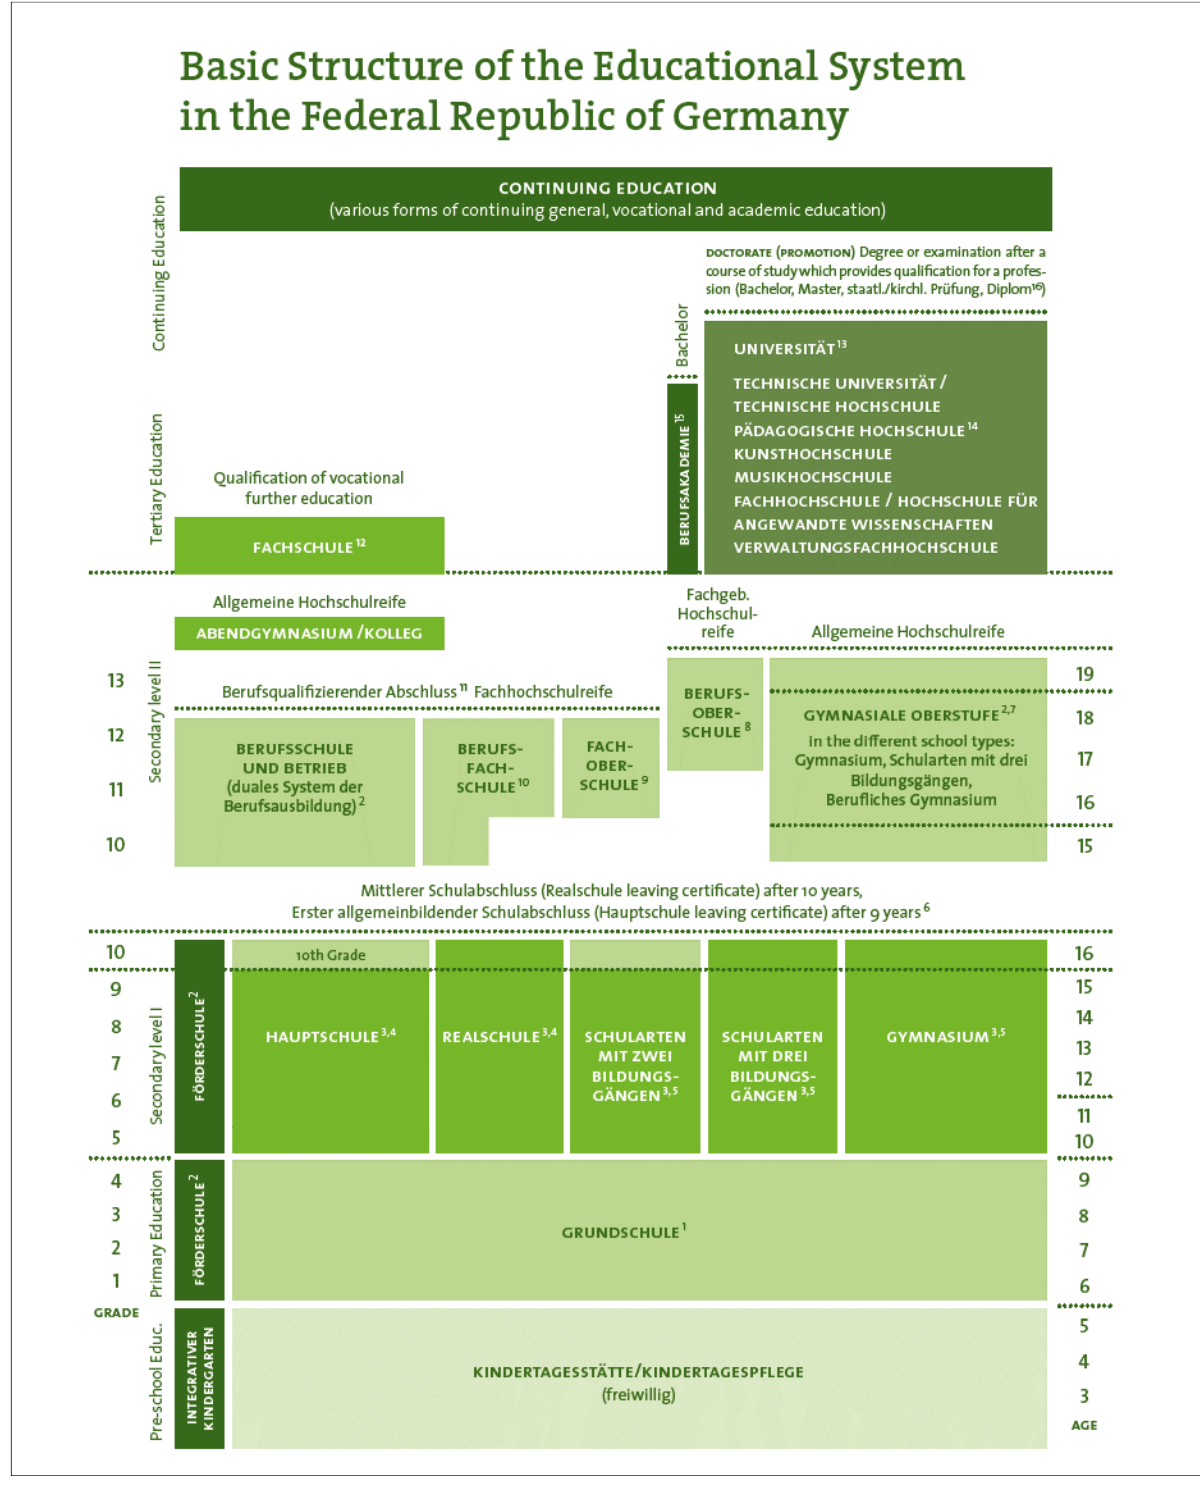
Figure A1. Basic structure of the German educational system.